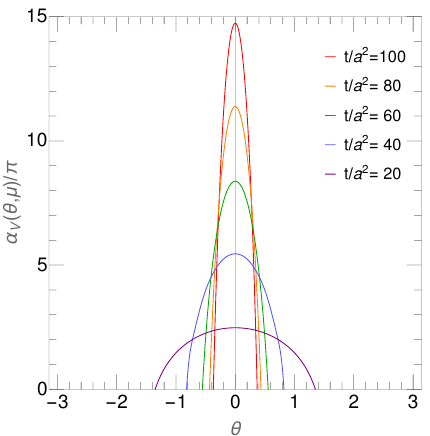
Figure 8. The running coupling α V p θ,µ q as a function of θ on the 24 4 lattice for flow times from t { a 2 “ 20 (bottom) to 100